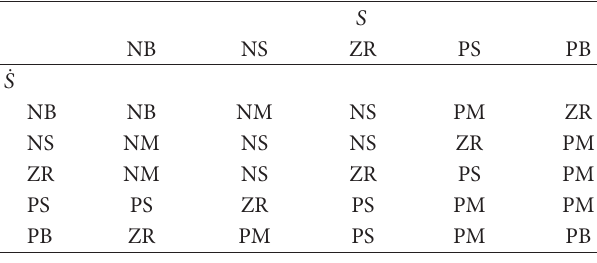
Table 2: Fuzzy rules of 𝜀 .